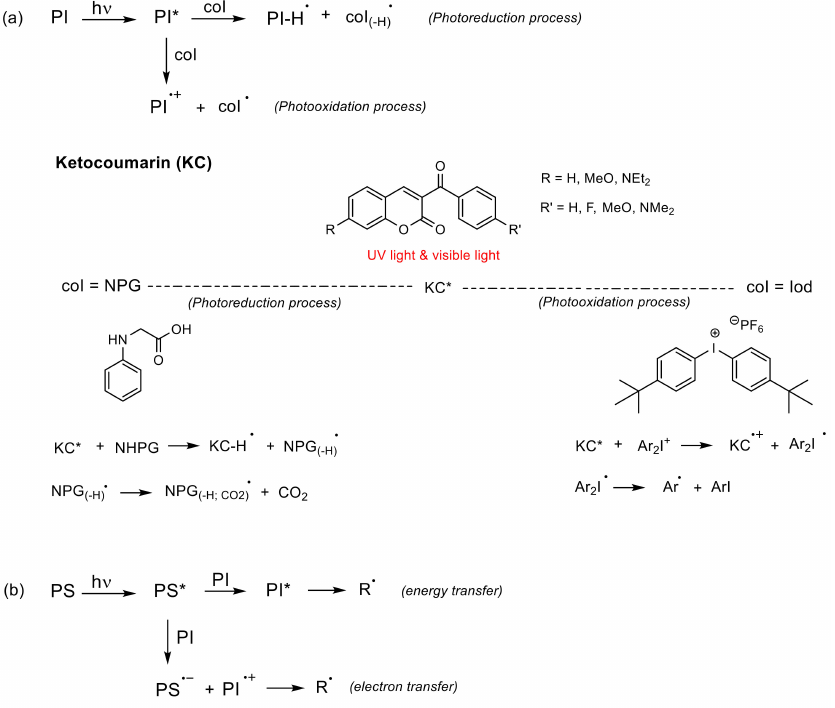
Figure 11. Bimolecular coumarin-based PIs. ( a ) Photoreduction process where the coI transfers an electron and a proton into the excited state of the PI, and photooxidation process where the excited state of PI transfers an electron into the coI; ( b ) The excited PS might transfer energy or an electron into the PI. The asterisk (*) denotes the excited state of the